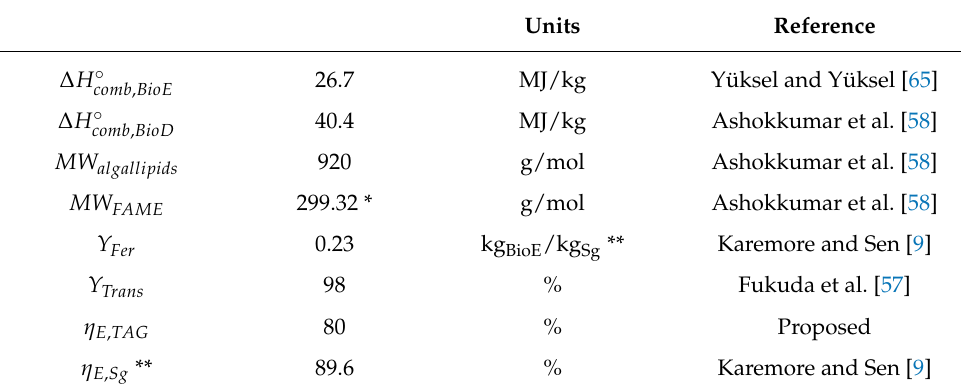
Table 3. Values used to calculate recoverable fuel energy of N. gaditana and P. kessleri . Units Reference ∆ H ◦ 26.7 MJ/kg Yüksel and Yüksel comb , BioE